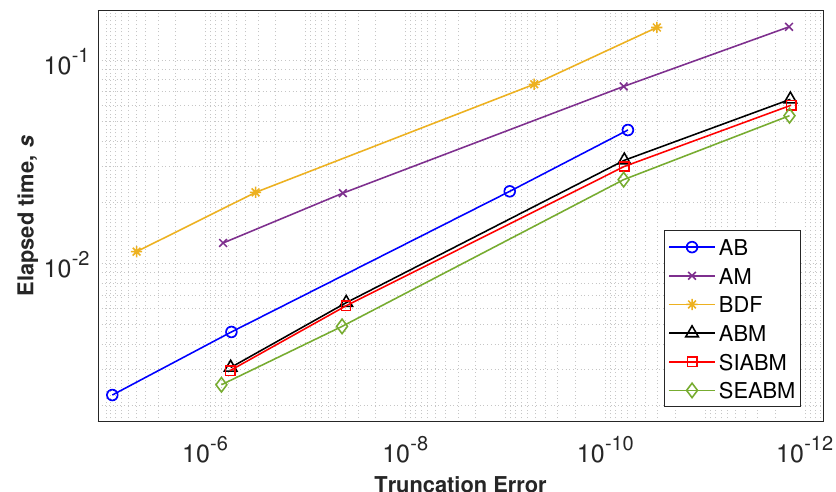
Figure 1. Performance plots for compared multistep ordinary differential equation (ODE) solvers while simulating system (6) with fixed